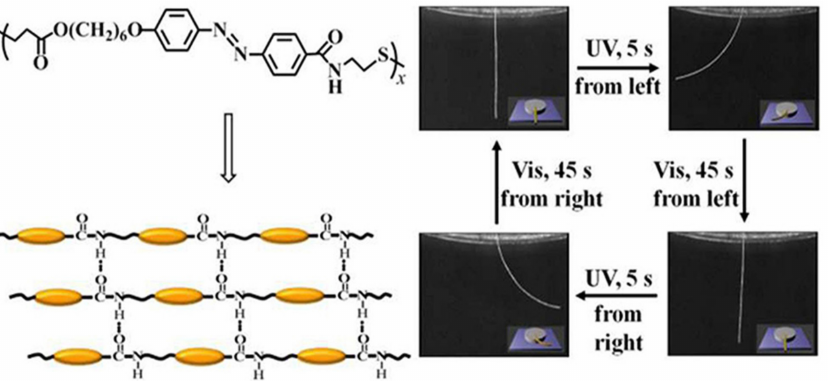
Figure 4. H-bonding self-assembly and photoinduced deformation upon irradiation with 365 nm UV light (150 mW cm − 2 ) and visible light ( λ > 510 nm, 120 mW cm − 2 ) at 25 ◦ C. Reprinted with permission from reference [107]. Copyright (2017) Royal Society of